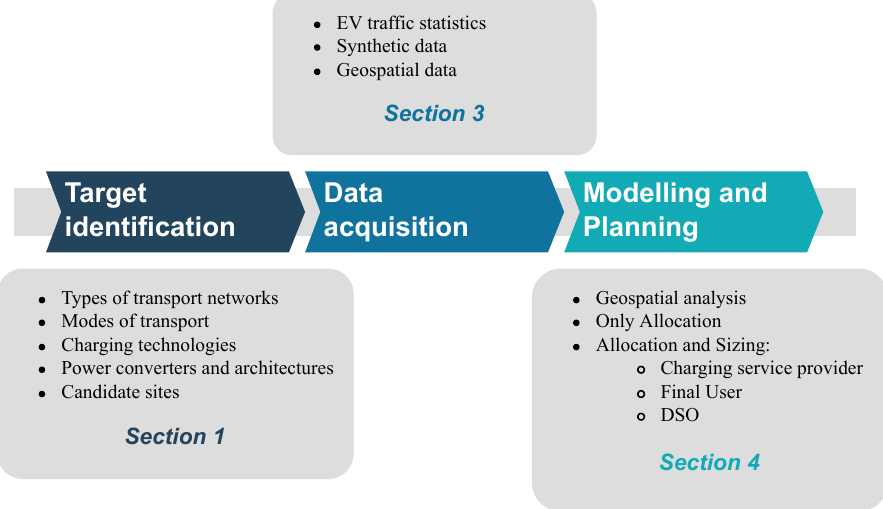
Figure 2. Structure of the review